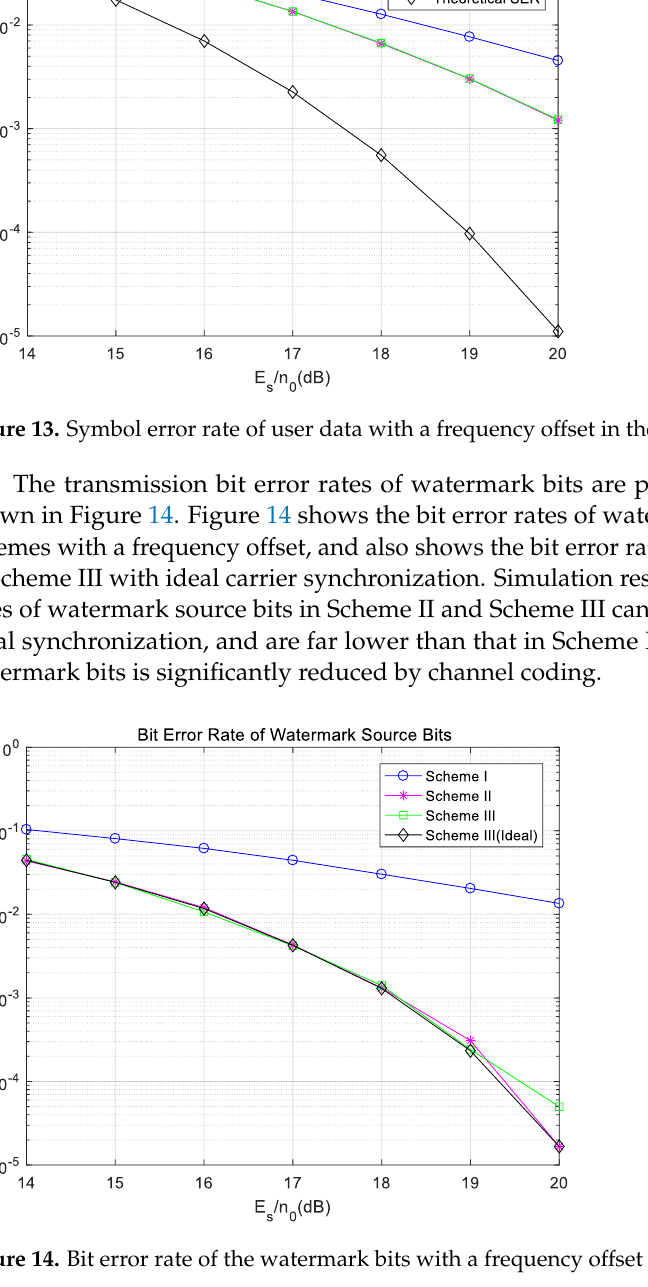
15 of 22 Figure 12. Success rates of watermark-bit transmission and watermark authentication under ideal synchronization in the Gaussian channel. 3.1.2. System Performance with Carrier Frequency Offset In the previous section, the system ’s performance under ideal carrier synchronization was analyzed. However, in practical applications, it is very difficult to achieve this condi- tion. When the frequency stability of a mobile phone is 0.1 ppm and the carrier frequency is 2.6 GHz, the possible carrier frequency offset is 260 Hz, and the 5G NR system is sensi- tive to frequency offsets. Therefore, this section takes the frequency offset of 90 Hz as an example to analyze the performance of the watermarking system. When the frequency offset is 90 Hz, the symbol error rate of the user’s signal is shown in Figure 13. The symbol error rates of user data in Scheme II and Scheme III are still very